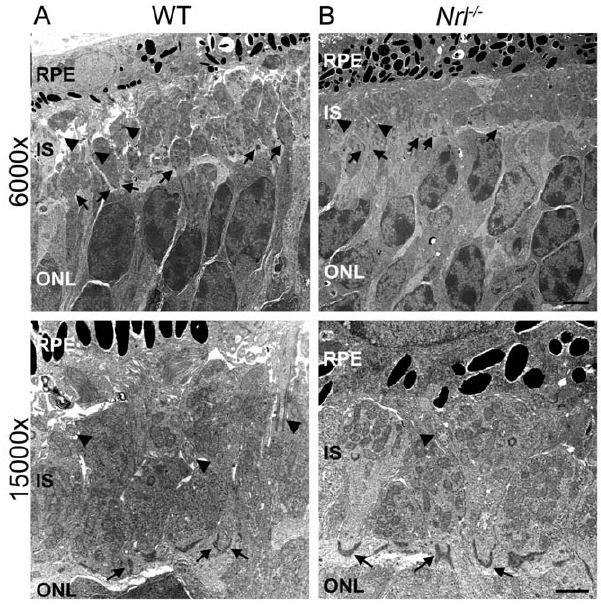
Figure 6. Ultrastructure of photoreceptor ISs of WT and Nrl 2 / 2 retinas at P8. The region between the RPE and the ONL at P8 in the WT (A) and Nrl 2 / 2 retina(B) is occupied by the well-formed ISs of photoreceptor cells and connecting cilia while OSs have not yet formed in the WT retina. Connecting cilia (arrowheads) can be observed in multiple orientations implying a lack of order in both WT and Nrl 2 / 2 retinas at P8 (A and B). Well-formed OLM junctions are also observed (arrows, A and B). Scale bar, 1 m m.